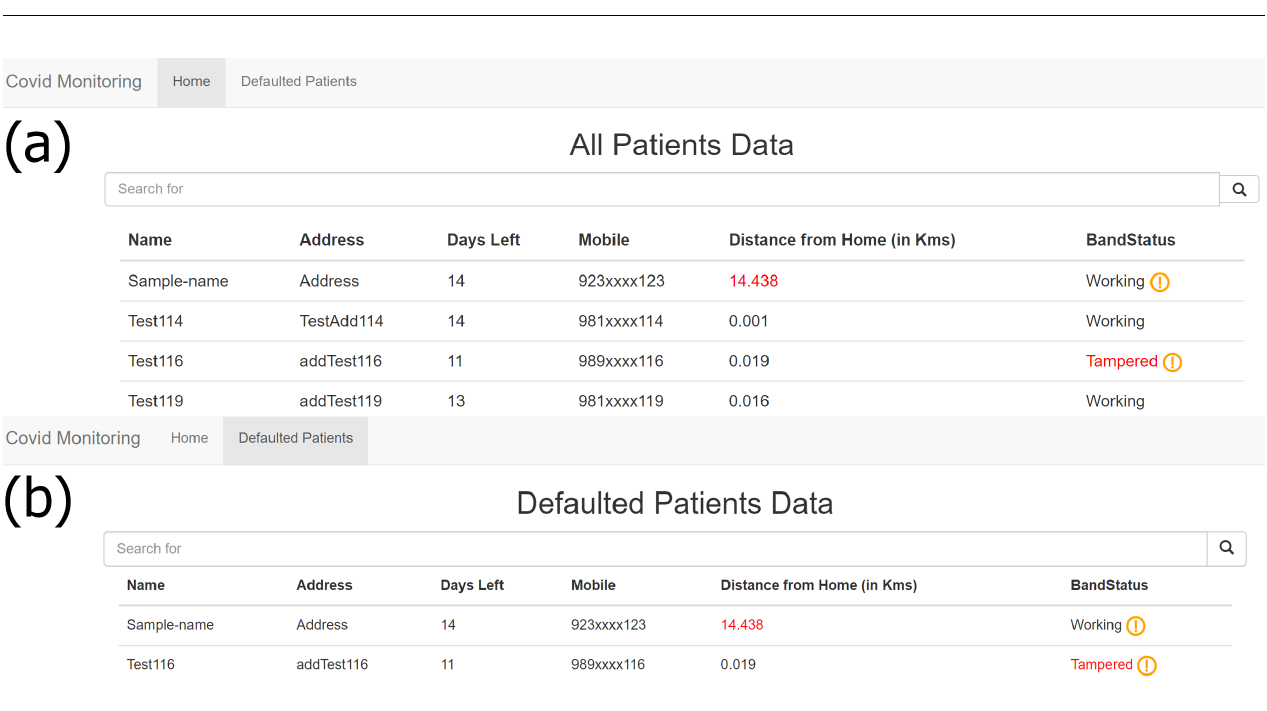
Figure 6. The IoT-Q-Band system’s monitoring web interface (a) displays the screen with all the test subject details, and (b) displays the screen with only possible defaulted subject